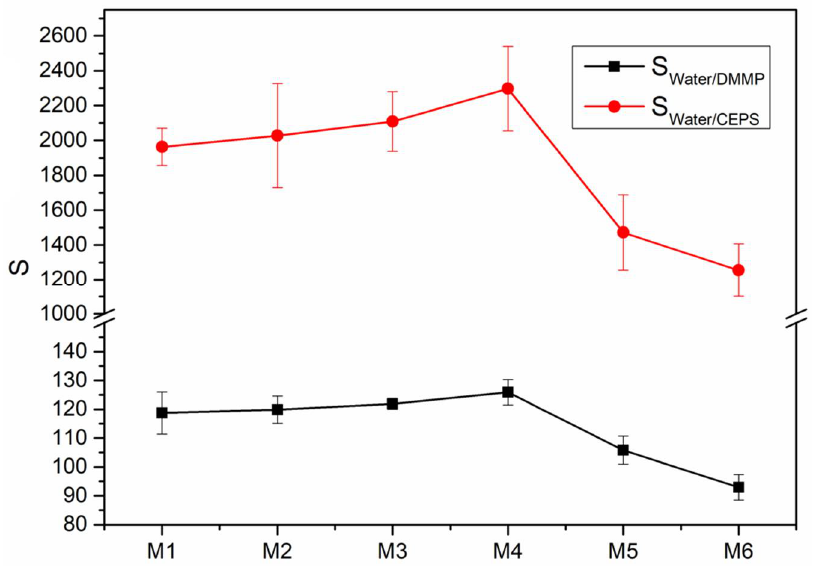
Figure 11. Selectivity of water/DMMP and water/CEPS for M1–M6.